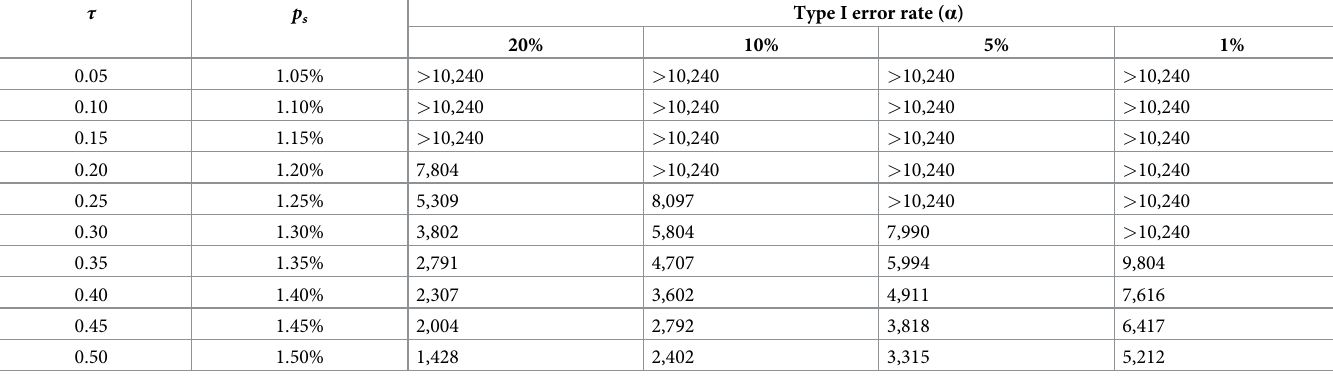
Table 7. Sample size required in order to obtain 80% power to detect that the probability of an adverse outcome is less than p assuming that the true probability of an adverse outcome = 0.01 (i.e.,